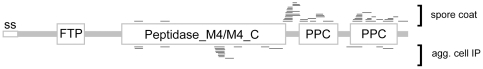
Mass spectrometry maps Protein C to FibA.Domain architecture of the 744 amino acid (aa) FibA preprometalloprotease as predicted by SMART (http://smart.embl-heidelberg.de) [54]. ss: signal sequence (aa 1–24); FTP: Fungalysin/Thermolysin Propeptide PFAM domain (aa 100–149); Peptidase _M4/M4_C: peptidase family M4 and M4-Cterminal PFAM domains (aa 218–518); PPC: Bacterial pre-peptidase C-terminal PFAM domain (aa 544–614 and 638–724). Black lines correspond to the length and sequence position of the peptides identified from mass spectrometry analysis of Protein C isolated from the spore coat (above schematic) or by immune-precipitation of the aggregated cell fraction using anti-Protein C sera (below schematic).